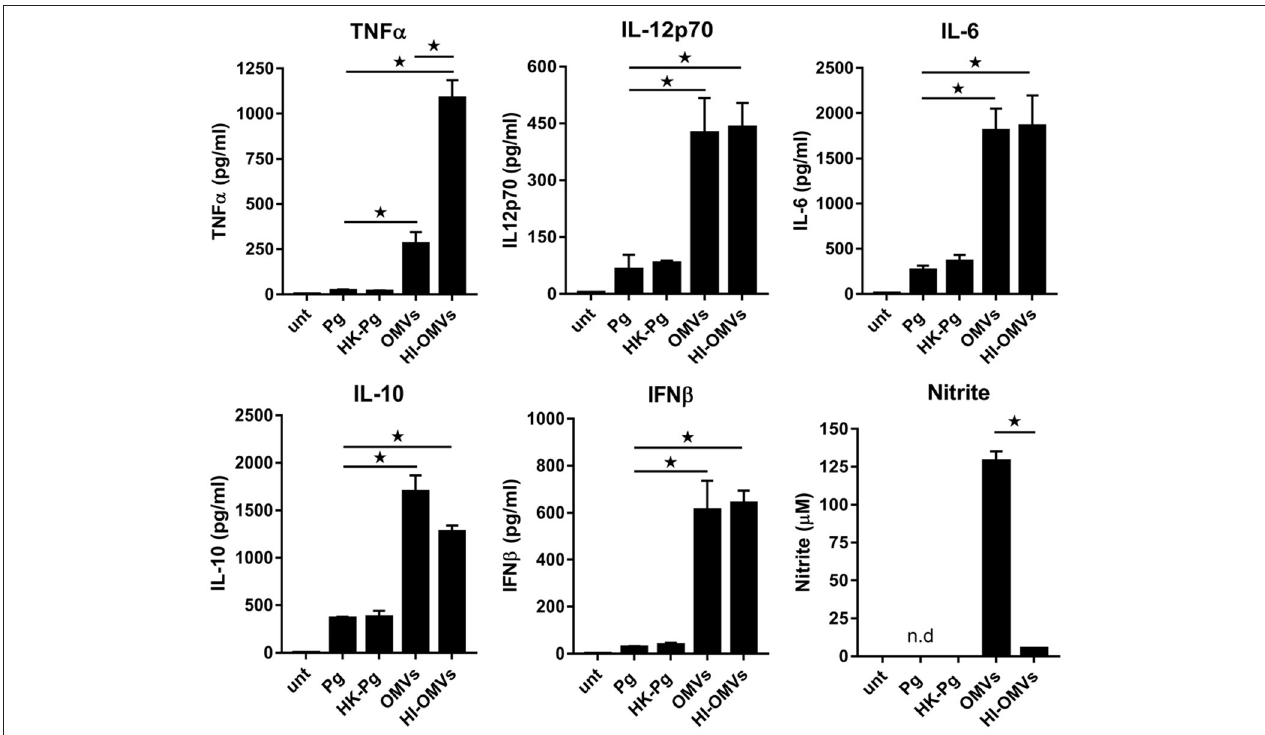
FIGURE 1 | P. gingivalis and its OMVs differentially induce macrophage cytokine and nitric oxide release. BMM were infected (2h at MOI of 25:1, see Materials and Methods) with viable P. gingivalis ( Pg ), heat-killed- Pg (HK- Pg ), OMVs or heat-inactivated-OMVs (HI-OMVs), and release of TNF α , IL-12p70, IL-6, IL-10, IFN β , and